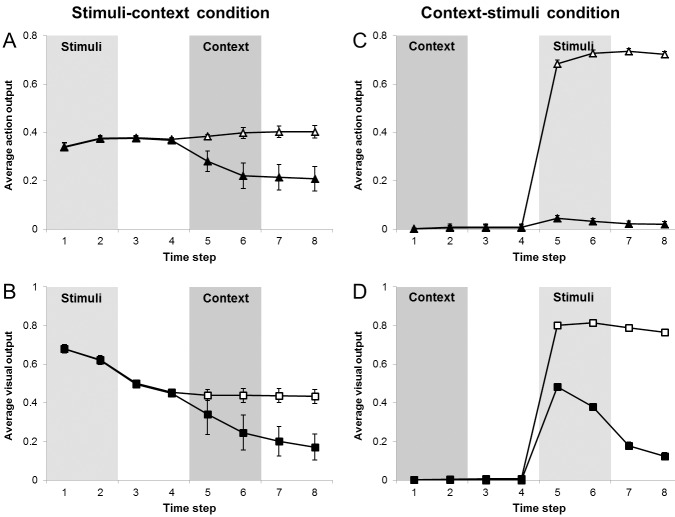
Average activation of the units encoding the relevant and the irrelevant stimulus as well as the correct and the incorrect action during eight successive processing steps.The processing steps in which the stimuli and the contextual information was provided are indicated on the top of each panel. (A) Experimental condition in which the presentation of the stimuli preceded the presentation of the context. (B) Experimental condition in which the presentation of the context preceded the presentation of the stimuli.